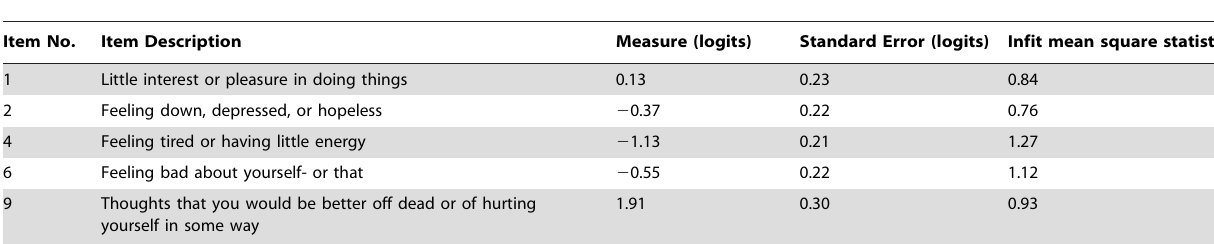
Table 4. Item calibration (location) and fit statistics for the five items of the Patient Health Questionnaire.